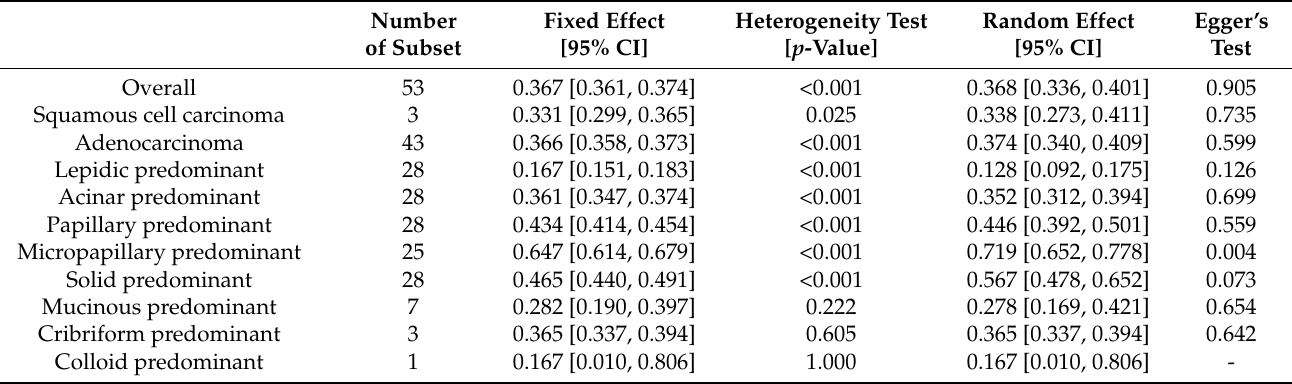
Table 2. Meta-analysis for the rate of spread through air space in non-small cell lung carcinoma.